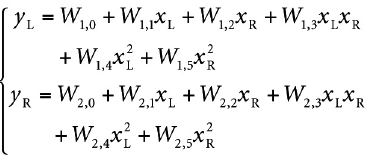
Figure 2 | Actual and simulated robot trajectories. Leftmost panel: Trajectories generated by the neuro- robotic system. The five light bulbs placed on the circular boundary of the workspace were turned on in sequence. Movements toward the lateral lights were curved, with an initial part in the forward direction, followed by a turn toward the light. The four panels on the right show the simulation results obtained after fitting the neural responses of the neural preparation with polynomial surfaces of various degrees, from linear to 4th degree.